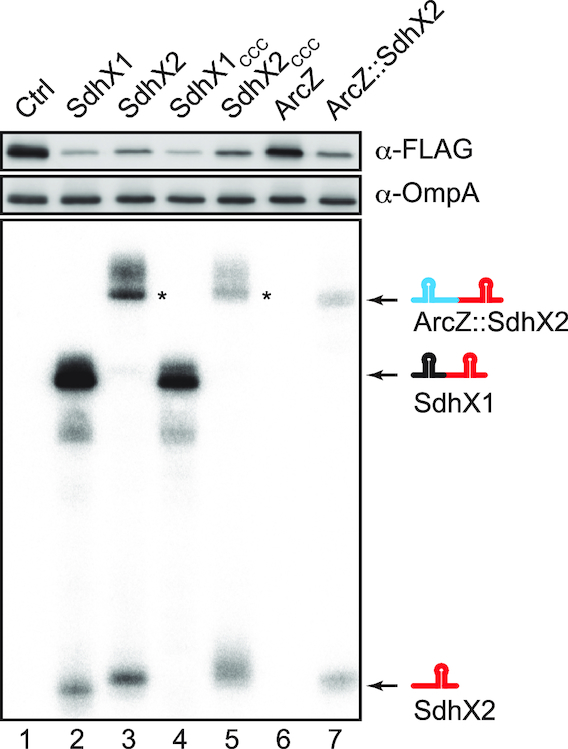
Processing of SdhX2 is not necessary for target regulation. Salmonella ΔsdhX mutant with C-terminal ackA::FLAG fusion was transformed by plasmids expressing respective sRNAs (lane 1: pJV300, lane 2: pLM1, lane 3: pLM30, lane 4: pLM34, lane 5: pLM35, lane 6: pJU-19, lane 7: pLM32). The slightly larger size of SdhX2 when expressed as a primary transcript (lane 3) may result from transcription starting at the –1 instead of the +1 position of the constitutive promoter used here. That is, SdhX2 starts with four uridines which are far from ideal for transcription initiation. Indeed, primer extension analysis revealed an extra nucleotide at the 5′ end of SdhX2 expressed from this plasmid (data not shown). The asterisk indicates a putative read-through product, whose transcription terminates at downstream rrnT1 in the vector (34).